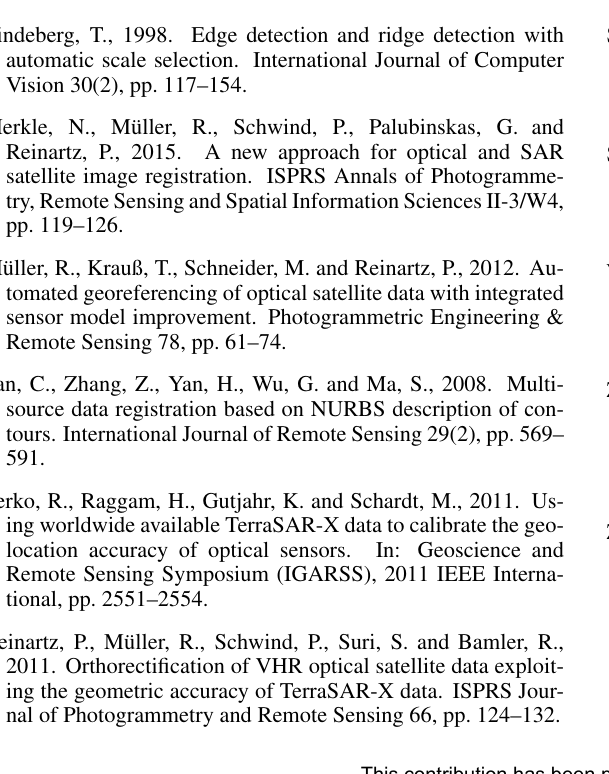
Figure 6: Chessboard overlays of overlap areas of the two QuickBird images. Figure (a) and (c) before, and (b) and (d) after the image